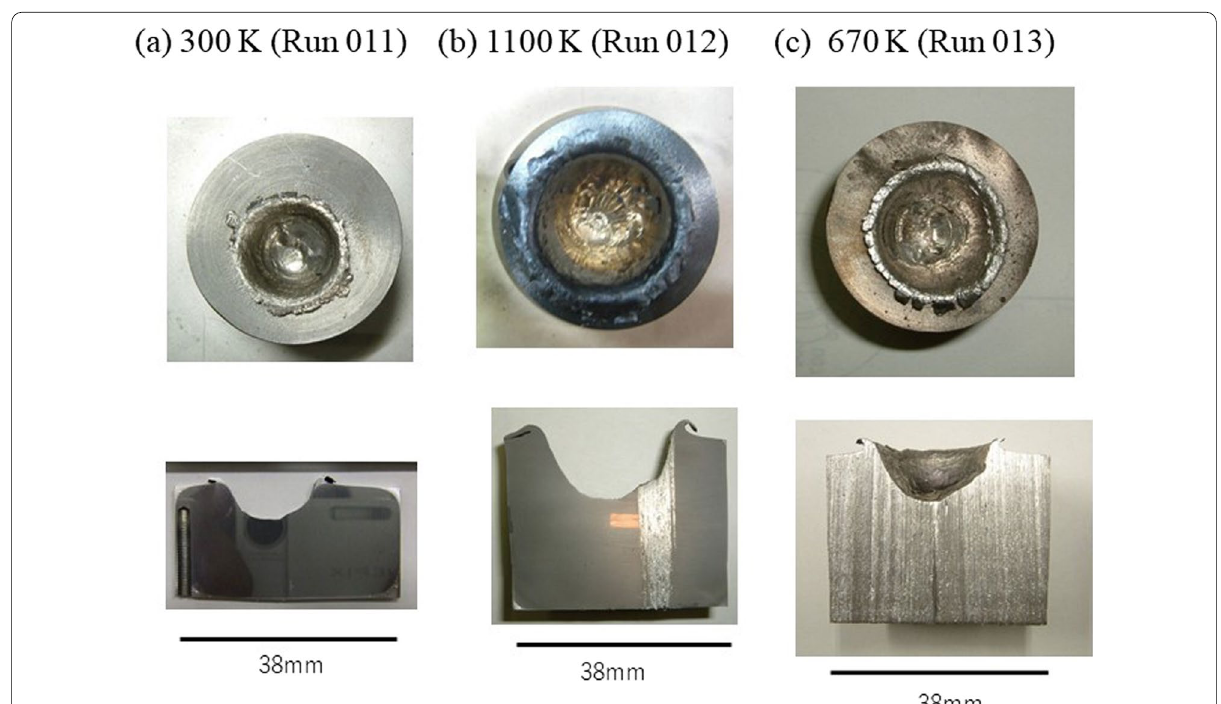
Fig. 4 The images of craters formed by impacts at room temperature (Run 011), ( a ), 1100 K (Run 012), ( b ), and 670 K (Run 013) ( c ), and their polished cross